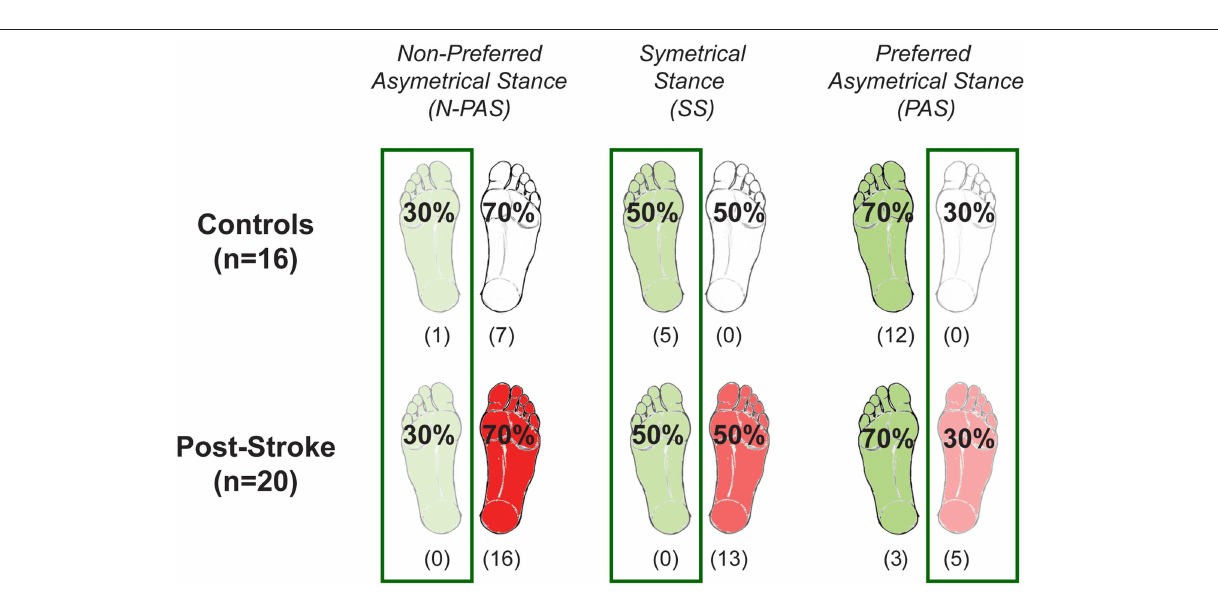
FIGURE 2 | Body weight distribution conditions. The three different weight-bearing (WB) conditions are represented here for the control and post-stroke participants. The preferred supporting leg is presented in green and the more-involved leg is presented in red for post-stroke paticipants. The numbers between parentheses indicates the number of participants who never stepped with that leg for any of the trials of that condition. Based on these numbers, the difference between groups was tested only when stepping with the preferred/less-involved leg for the N-PAS and SS conditions, and with the non-preferred/more-involved leg for the PAS condition, whereas difference between legs was tested in the N-PAS and SS conditions for controls, and for stroke participants in the condition with the same body weight distribution (i.e., less-involved in the N-PAS condition and more-involved in the PAS